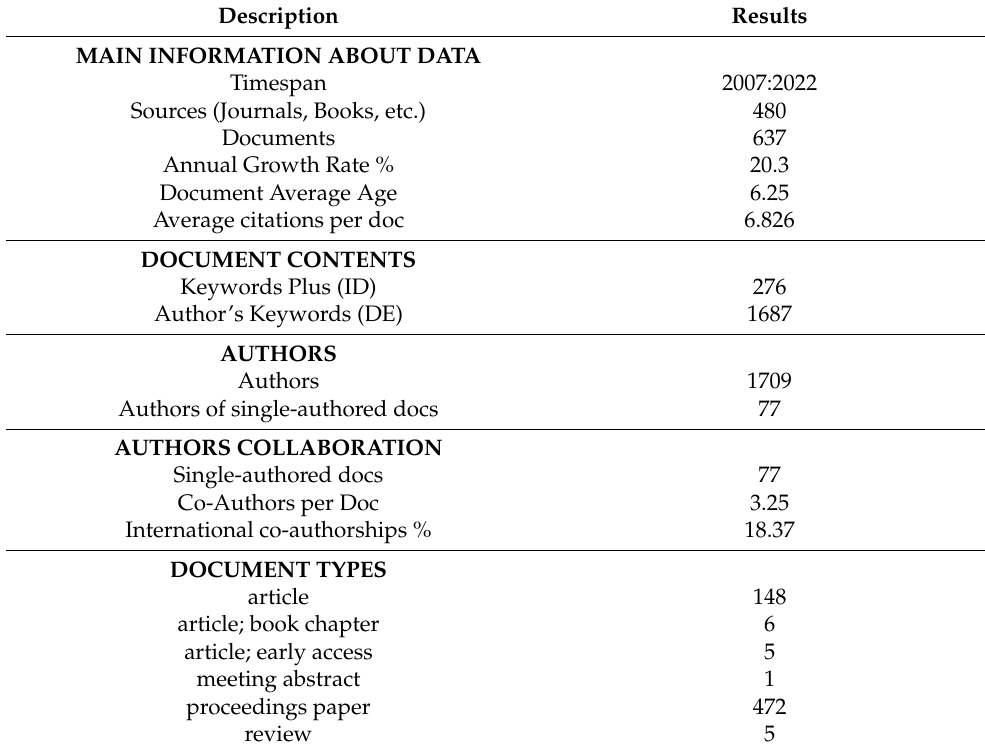
Table 3. Descriptive elements of the set of documents (Source: Biblioshiny, based on WoS data). Description